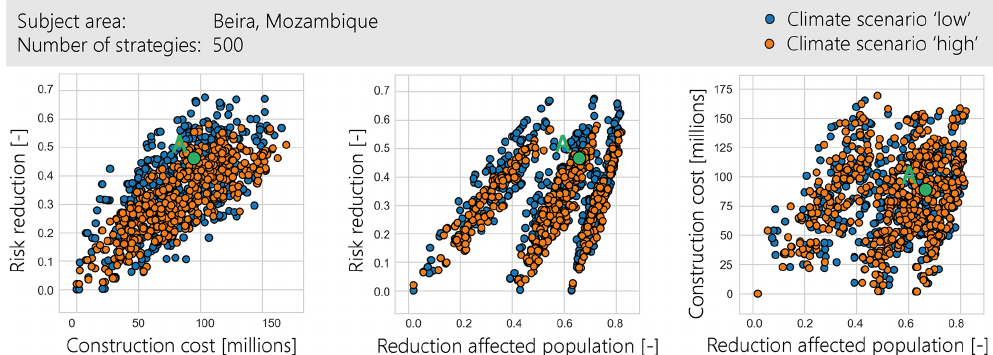
Figure 8. Pair-wise plotting graphs for the Beira case study. Each dot represents one flood risk reduction strategy. Each strategy can be assessed by its risk reduction, reduction of affected population, and cost of construction. Here, those outcomes are plotted against each other. Different colors indicate two different future climate scenarios. A represents a strategy consisting of four measures: (1) dunes on the eastern coast (10.5m + CD), (2) a flood wall on the southwestern coast (9m + CD), (3) enhancement of the drainage system, and (4) enhanced evacuation of vulnerable neighborhoods. Table 4. Results of PRIM analysis for the Beira case study. “Goals” shows what output we are looking for (i.e., minimum risk reduction, maximum budget). “Start” shows how many strategies out of the initial 500 comply with the goals, called strategies of interest. “Results” shows design choices that are made, focusing on these strategies of interest. “Final” indicates how many strategies are left after filtering for the design choices listed under “Results” and how many of those are still strategies of interest. Goals Start Results Final Strategies of interest Design choices (priority from top down) Strategies of